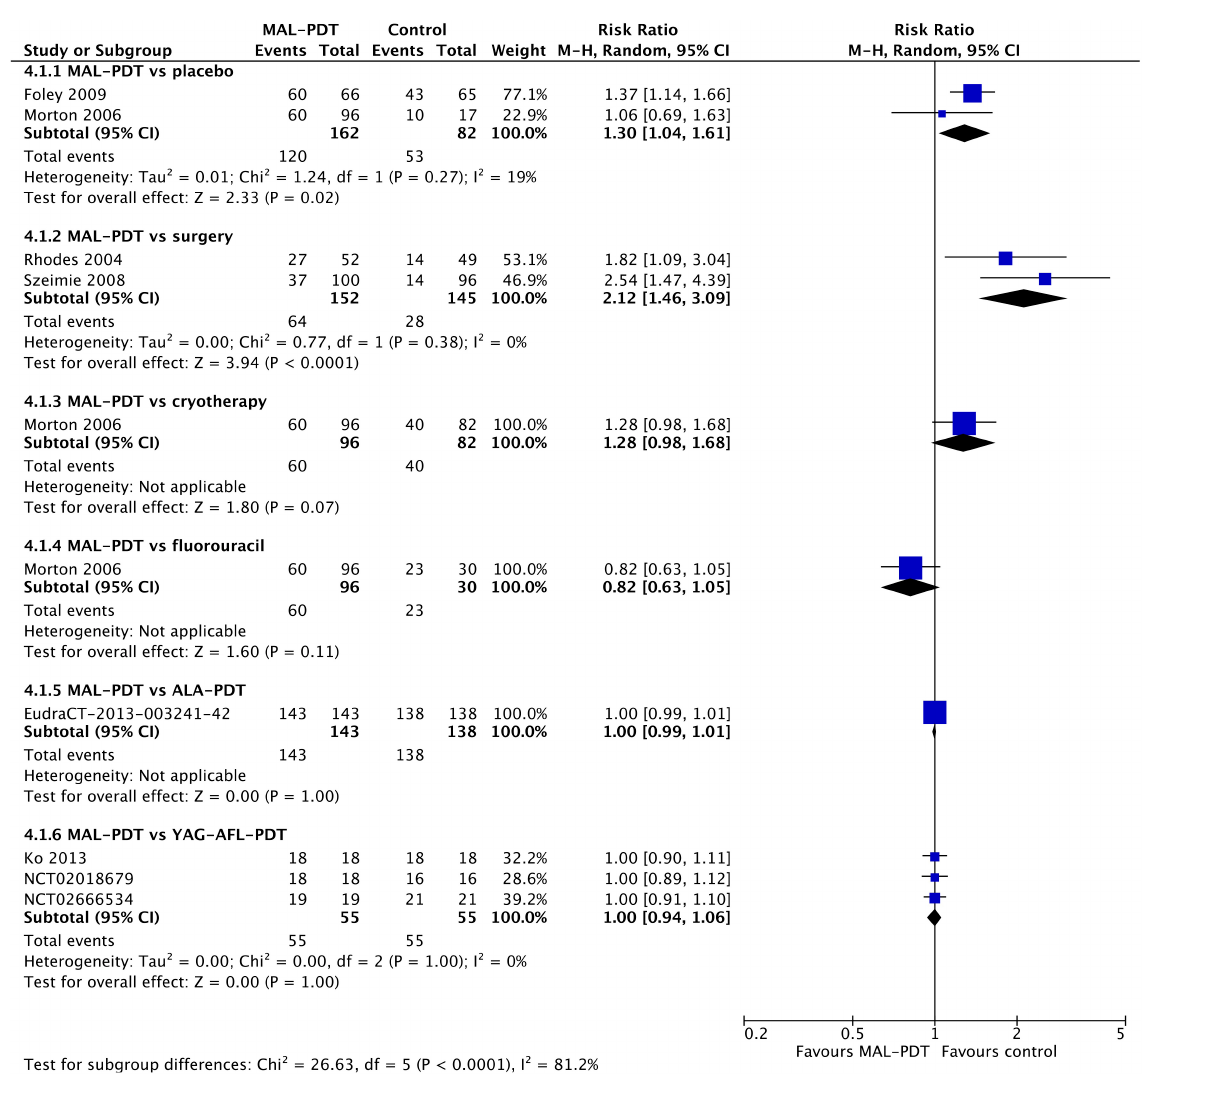
FIGURE7 Meta-analysis of the risk of adverse events by comparator. Data are risk ratios with 95% confidence